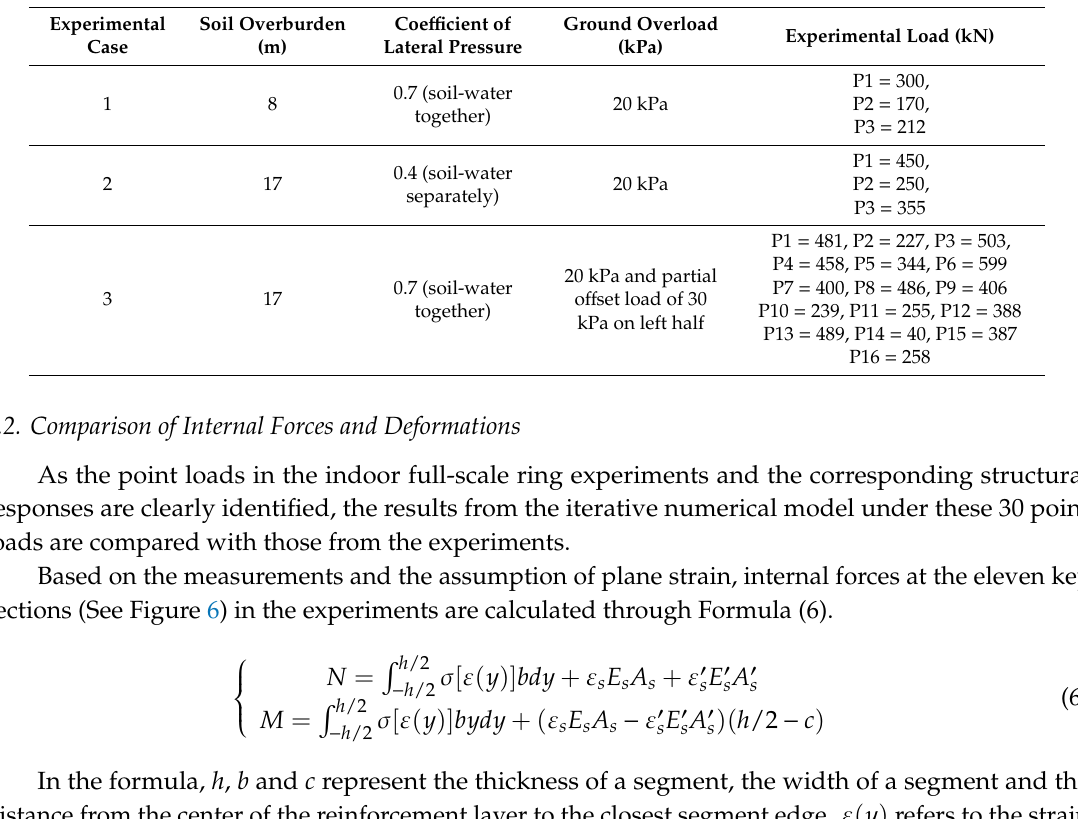
Table 2. Full-scale ring experimental